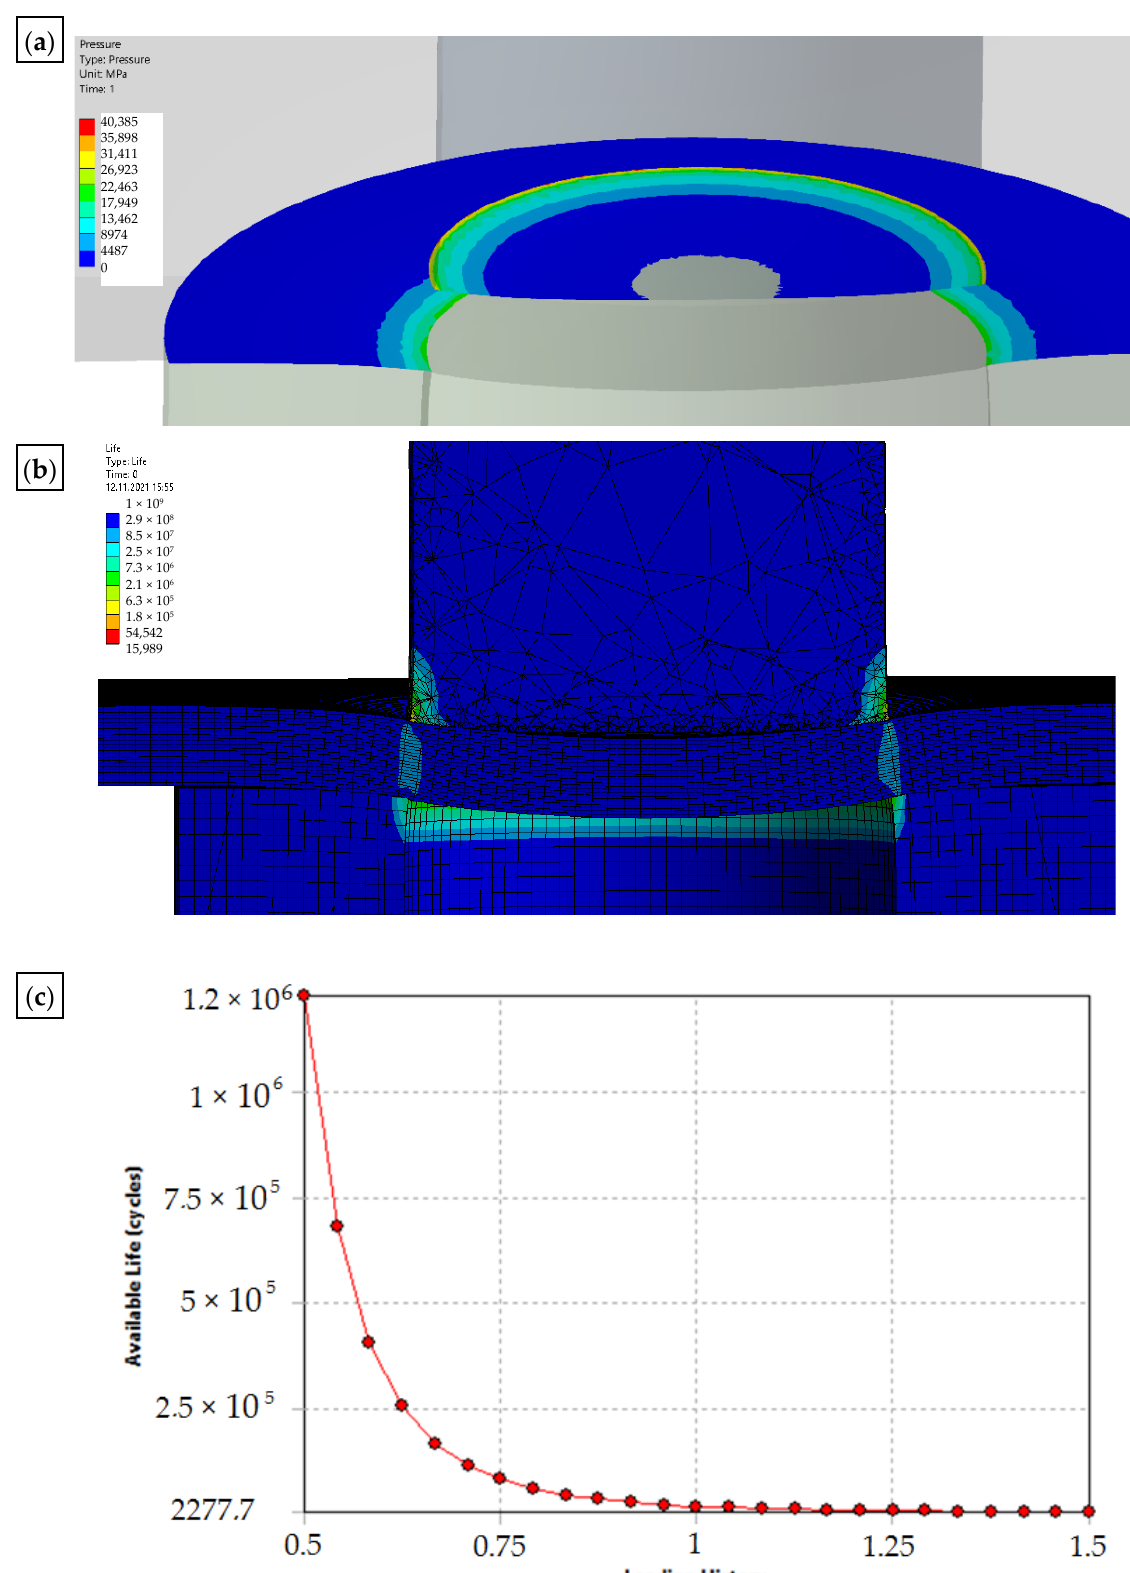
Figure 12. The state of reduced stresses in the tool and the punched sheet for various levels of ad- vancement of the process: ( a ) for 3% advancement; ( b ) for 10% advancement; ( c ) for 80% advance- ment [MPa].